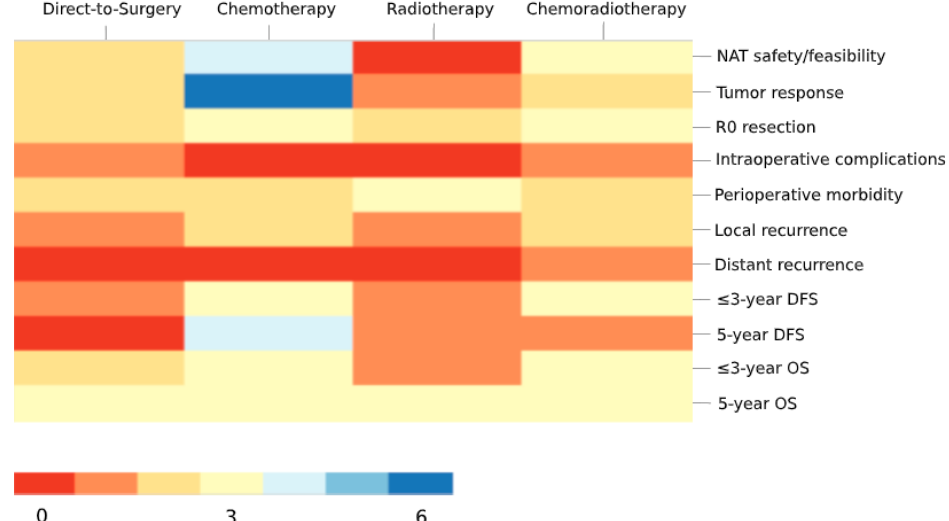
Figure 2. Heatmap graphic showing the distribution of primary outcomes in the current literature on neoadjuvant therapy for T4 colon cancer. Each box in the grid represents the number of studies (color coded per the legend) that use the primary outcome listed on the y -axis to evaluate the neoadjuvant therapy listed on the x -axis. NAT, neoadjuvant therapy; R0, microscopically negative margins; DFS, disease-free survival; OS, overall survival.